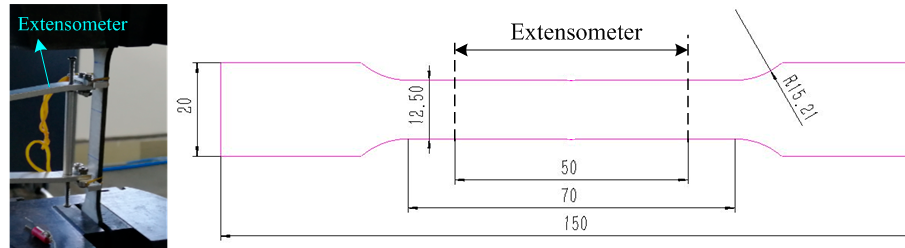
Table 1. Standard chemical composition of SUS304 stainless steel (wt%).